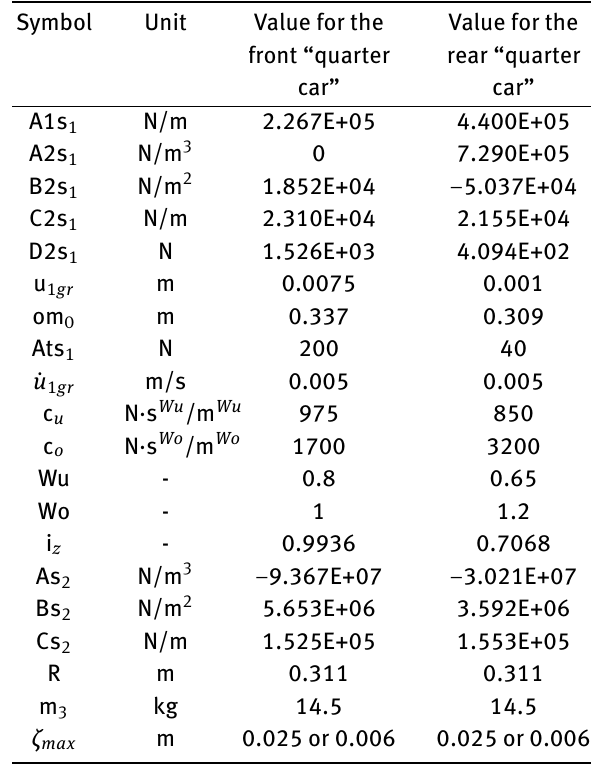
Table 2: Additional parameters of the nonlinear model and the diagnostic